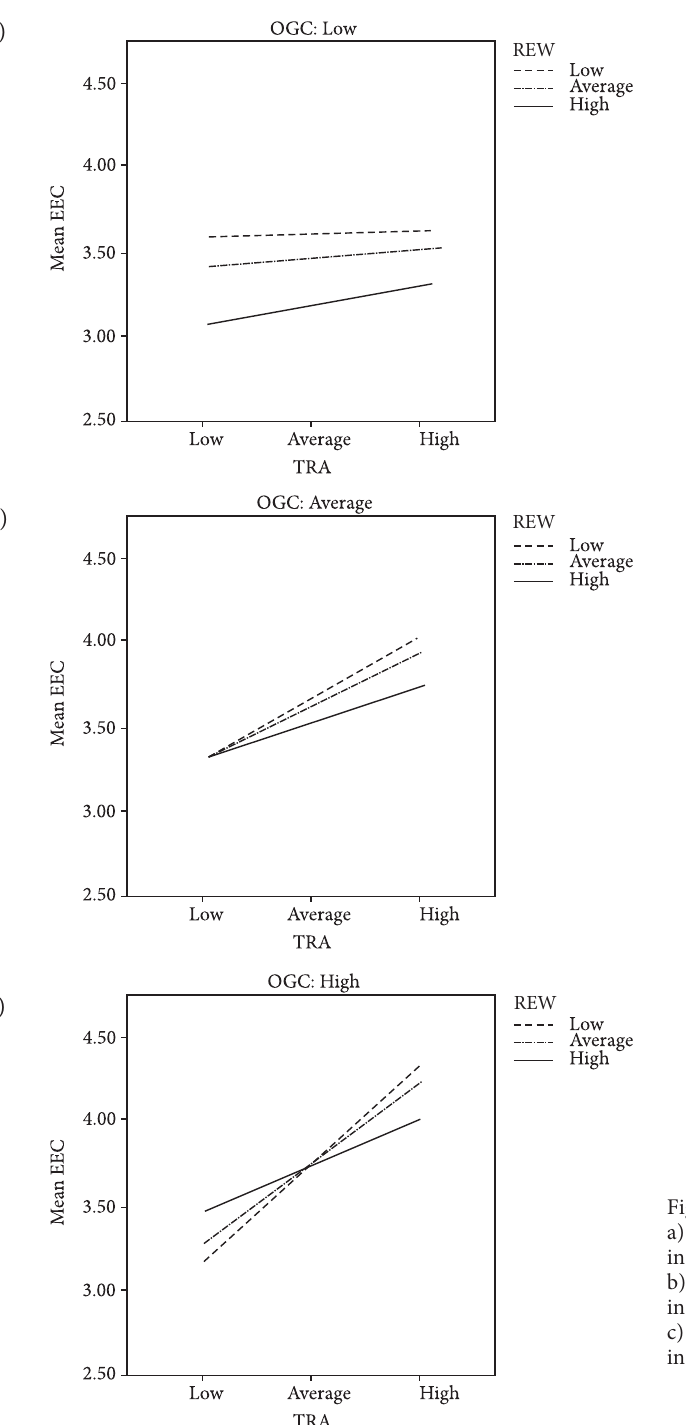
Figure 3: a) The conditional